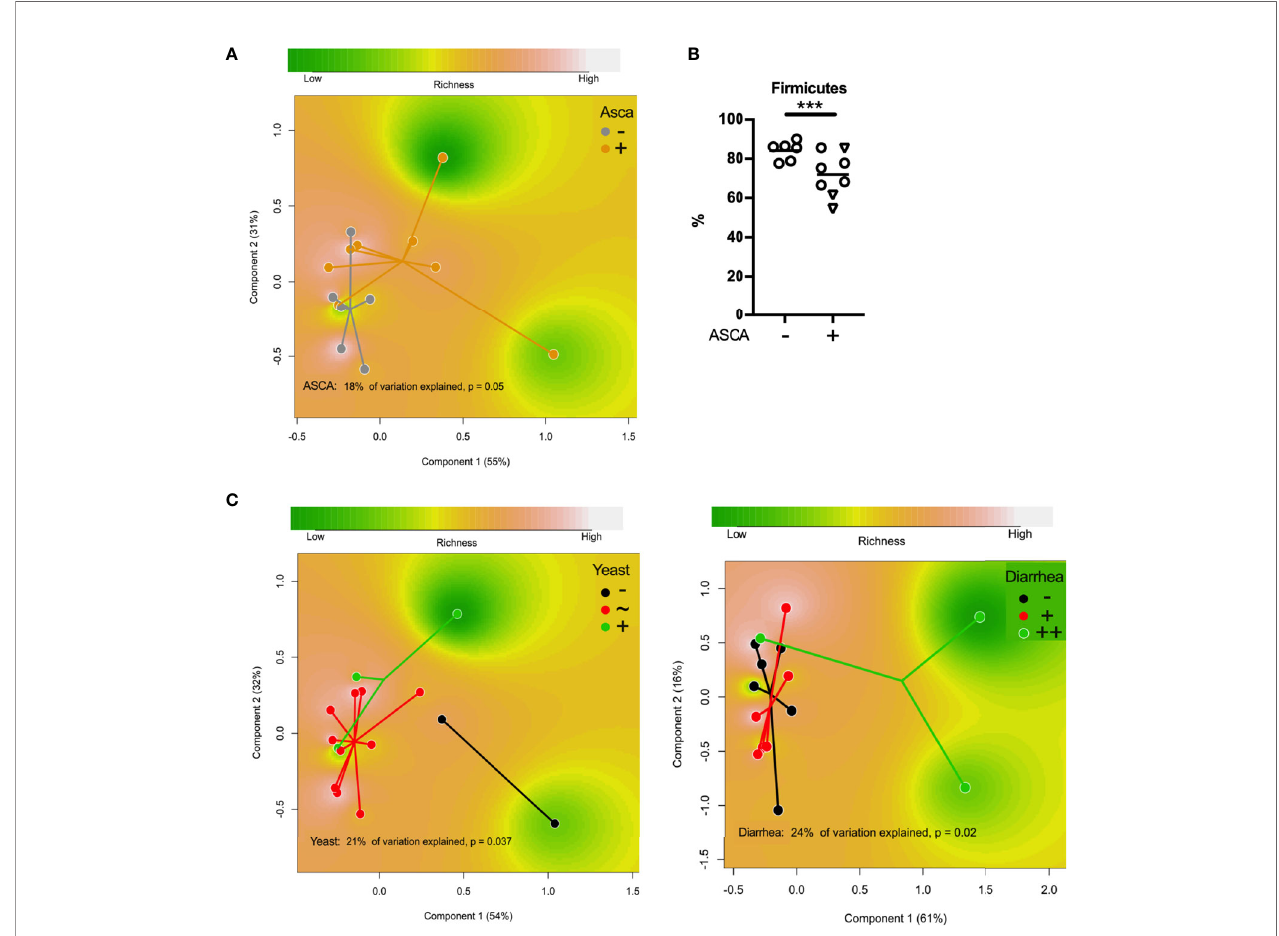
FIGURE 4 | (A) Principal coordinate analysis (PCoA) based on Bray – Curtis distances using the phylum-level data showing differences in the gut microbiota compositions between ASCA-positive and ASCA-negative patients with APECED. (B) The relative abundance of Firmicutes in patients with or without ASCA. (C) Principal coordinate analysis (PCoA) based on Bray – Curtis distances using the genus-level data showing differences in the gut microbiota compositions between patients with APECED ranked according to abundance of yeast in stool and the severity of patient ’ s gastrointestinal symptoms, respectively. *** denotes p-value < 0.001; – , negative/low; +, positive; ++, markedly positive ie. severe symptoms; ~,